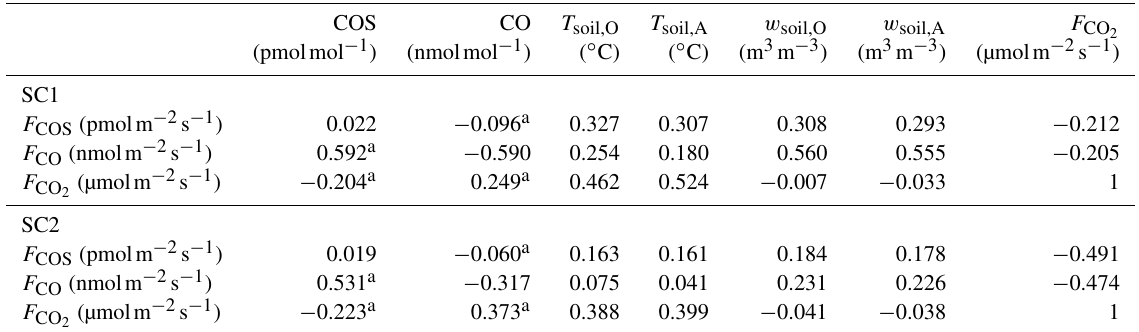
Figure 3. Monthly-mean diurnal trends of apparent deposition velocities of COS and CO ( − F COS / [ COS ] 0 . 5m and − F CO / [ CO ] 0 . 5m ) in the two chambers, averaged in 1h bins. Different monthly periods are color-coded. Table 2. Pearson correlations between fluxes and environmental variables for the two soil chambers. T soil,O and T soil,A are soil temperatures in the humus layer and in the A horizon, respectively. Similarly, w soil,O and w soil,A are soil moisture (m 3 m − 3 ) in the humus layer and in the A